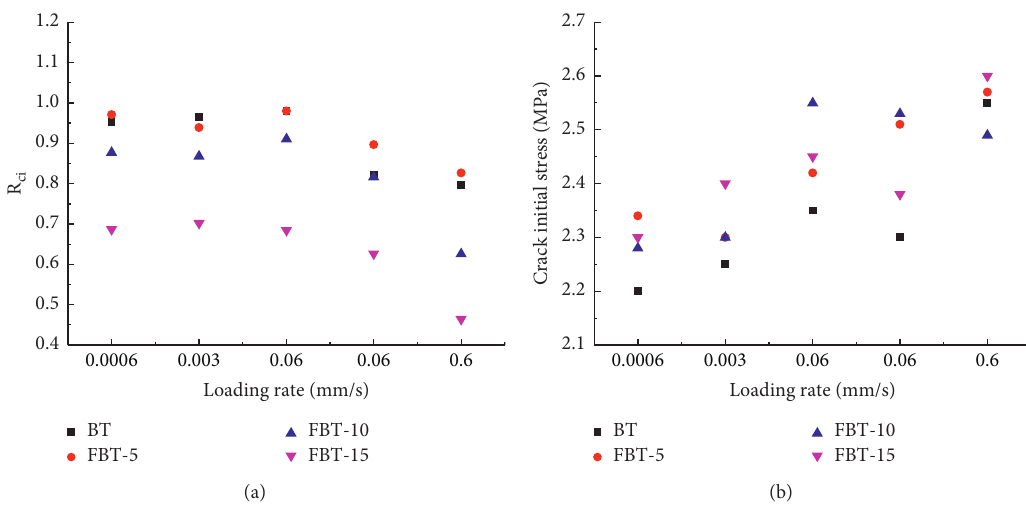
Figure 17: Crack initiation ratios and tensile strengths using the crack initiation